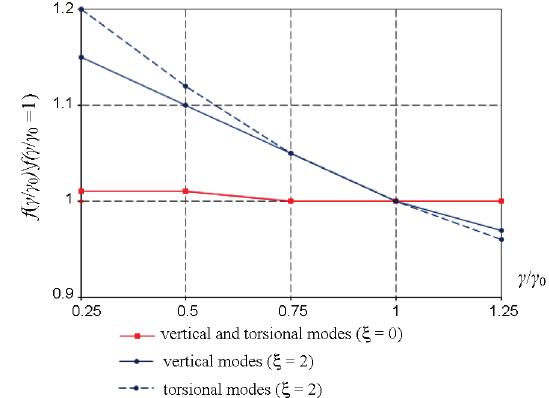
Fig. 10. The ratio between the frequency of the model with the variable mass f ( γ/γ 0 ) of the cable and that of the original system f ( γ/γ 0 = 1 ) for all vertical and torsional modes versus the ratio γ / γ 0 of the mass density of the cable considering two values of stiffness parameters ξ = 0 and ξ = 2.0 of the cable